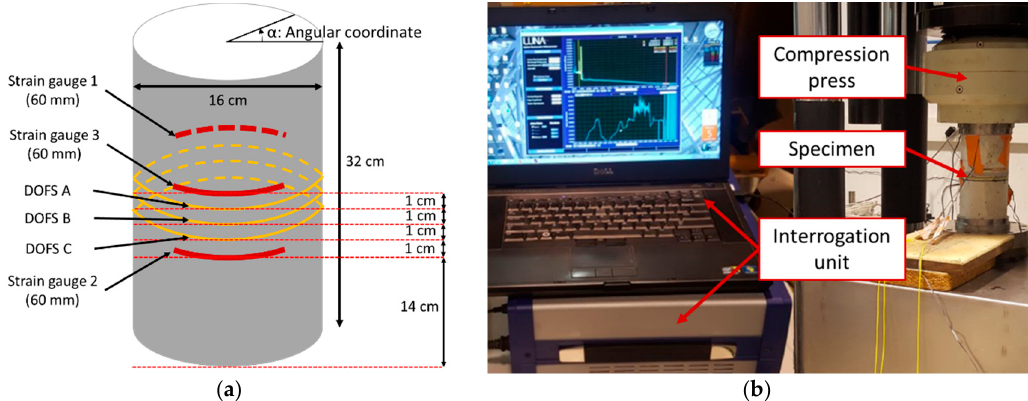
Figure 7. ( a ) Schematic description of the compressive test specimen; ( b ) experimental setup used for the compression test and the interrogation of DOFS.